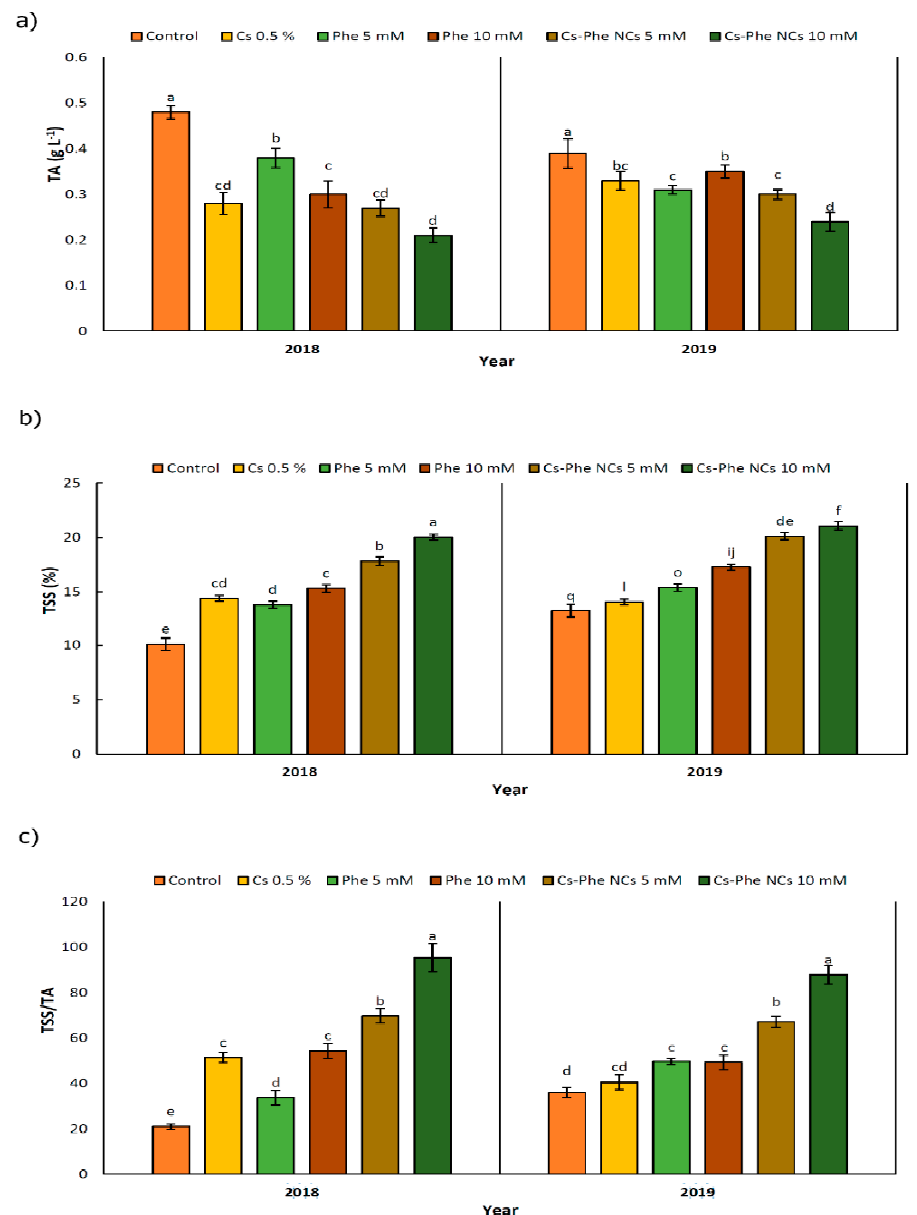
Figure 3. Effects of 0 (control), Cs (0.5%), Phe (5 and 10 mM), and CS–Phe NCs (5 and 10 mM) on the TA ( a ), TSS ( b ), and TSS/TA ( c ) of V. vinifera cv. Flame Seedless berries. The SDs denoted by lowercase letters in the same treatment indicate significant differences at p < 0.05 according to Duncan’s test.